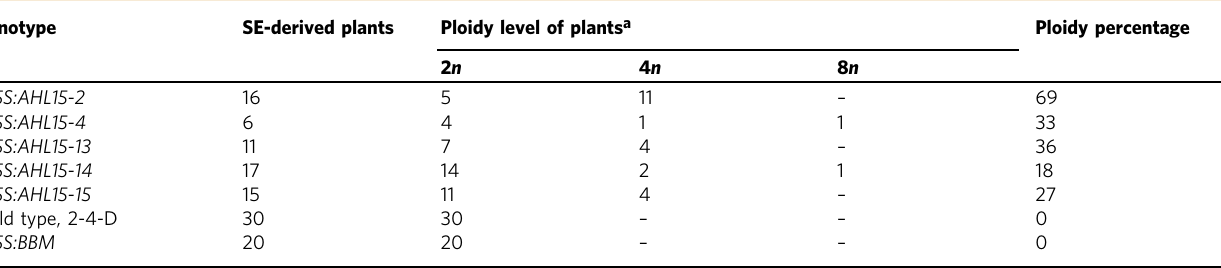
Table 1 Ploidy level of plants derived from SEs induced by AHL15 overexpression, BBM overexpression or by 2,4-D treatment.